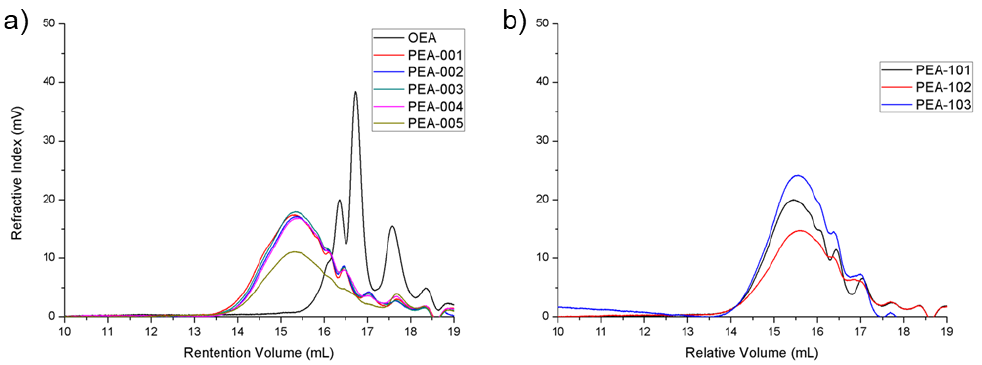
Figure 3. GPC traces of all PEAs synthesized in the course of this study. (a) PEA-001-005; (b)